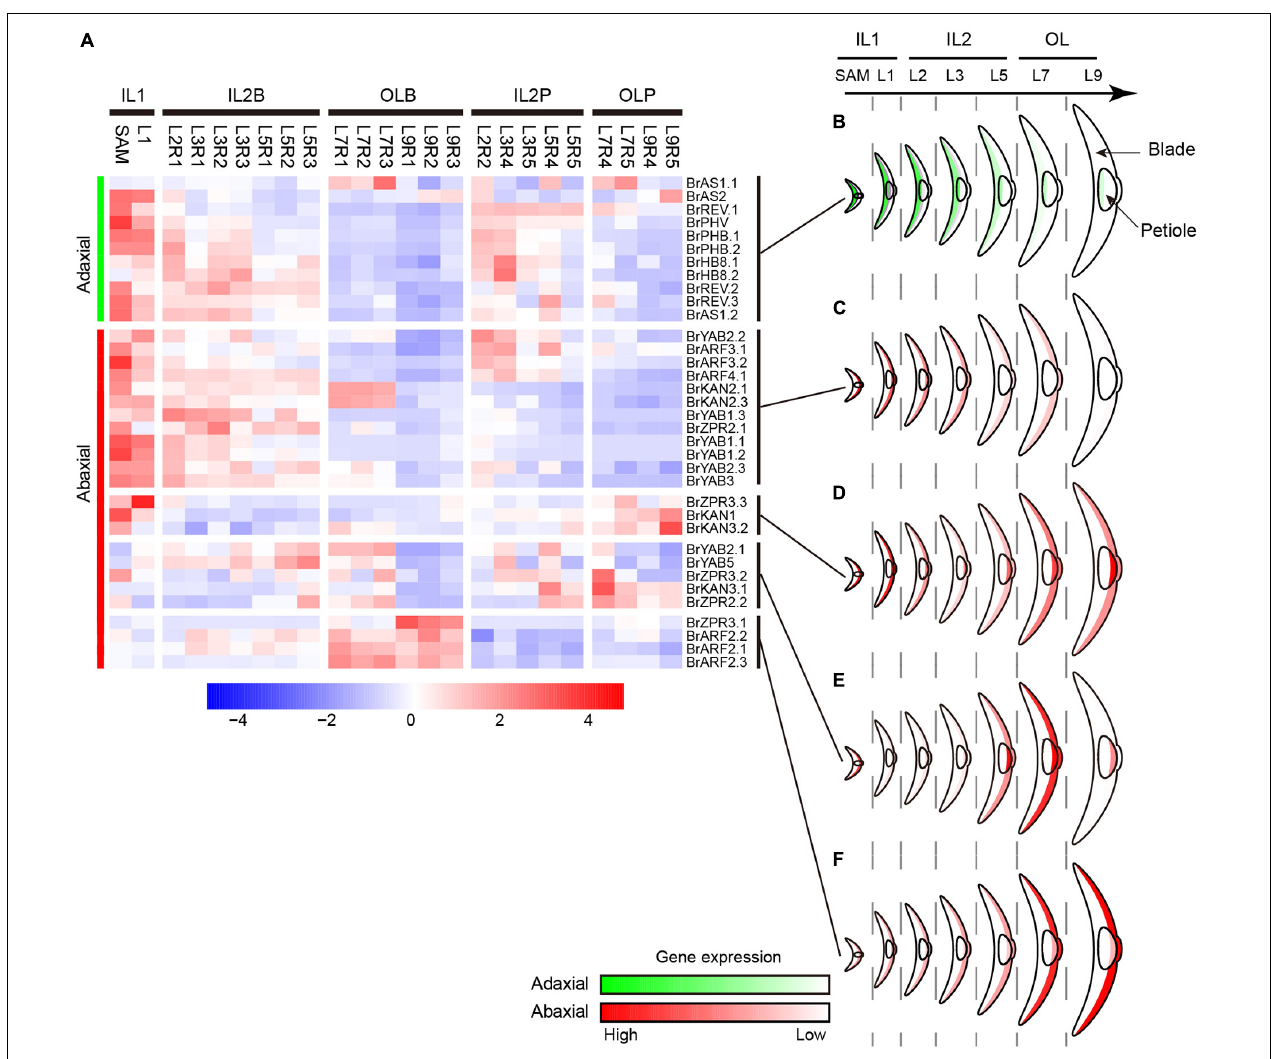
FIGURE 4 | Expression profiles of ad-ab polarity genes. (A) Expression characteristics of ad-ab polarity genes in leafy head. For each gene, expression data were Z-score standardized. (B) Expression pattern of adaxial genes. (C–F) Four expression patterns of abaxial genes. Crescent indicated transverse section of a